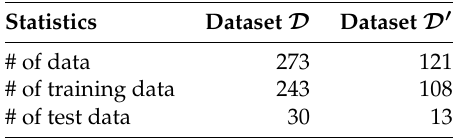
Table 4. Statistics of datasets used in experimental